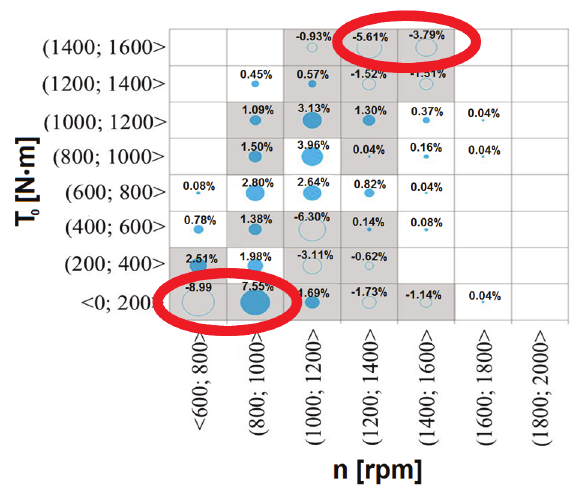
Fig. 26. Difference in the operating time density of test vehicles between measurements on the test route and in the SORT 2 test, shown in the